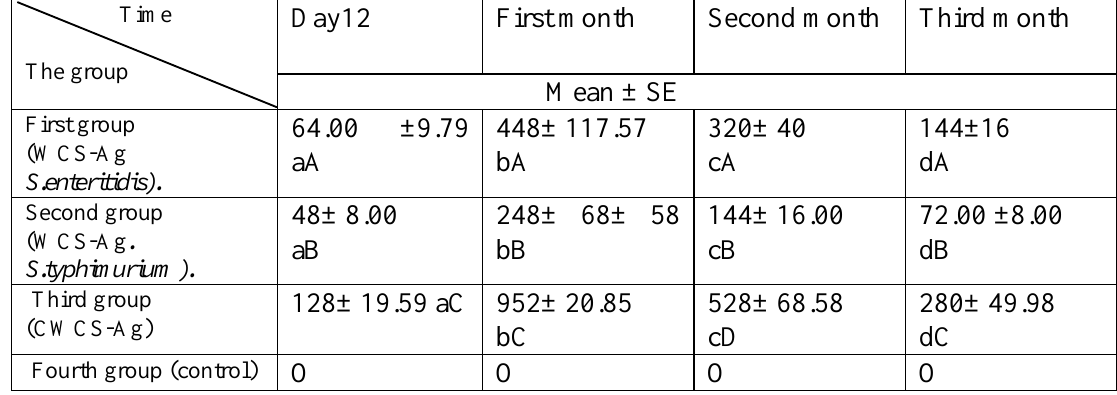
Table -1: Mean of antibodies titers of rabbits vaccinated with WCS –Ags by tube agglutination test:-